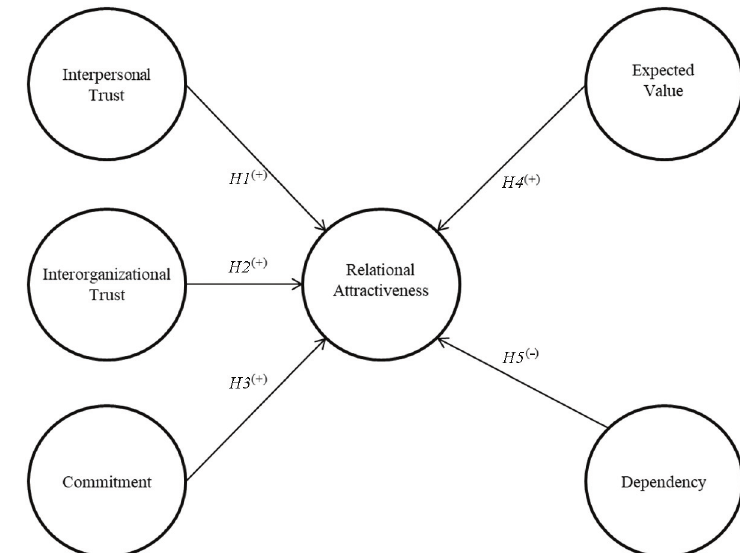
Figure 1. Conceptual integrative